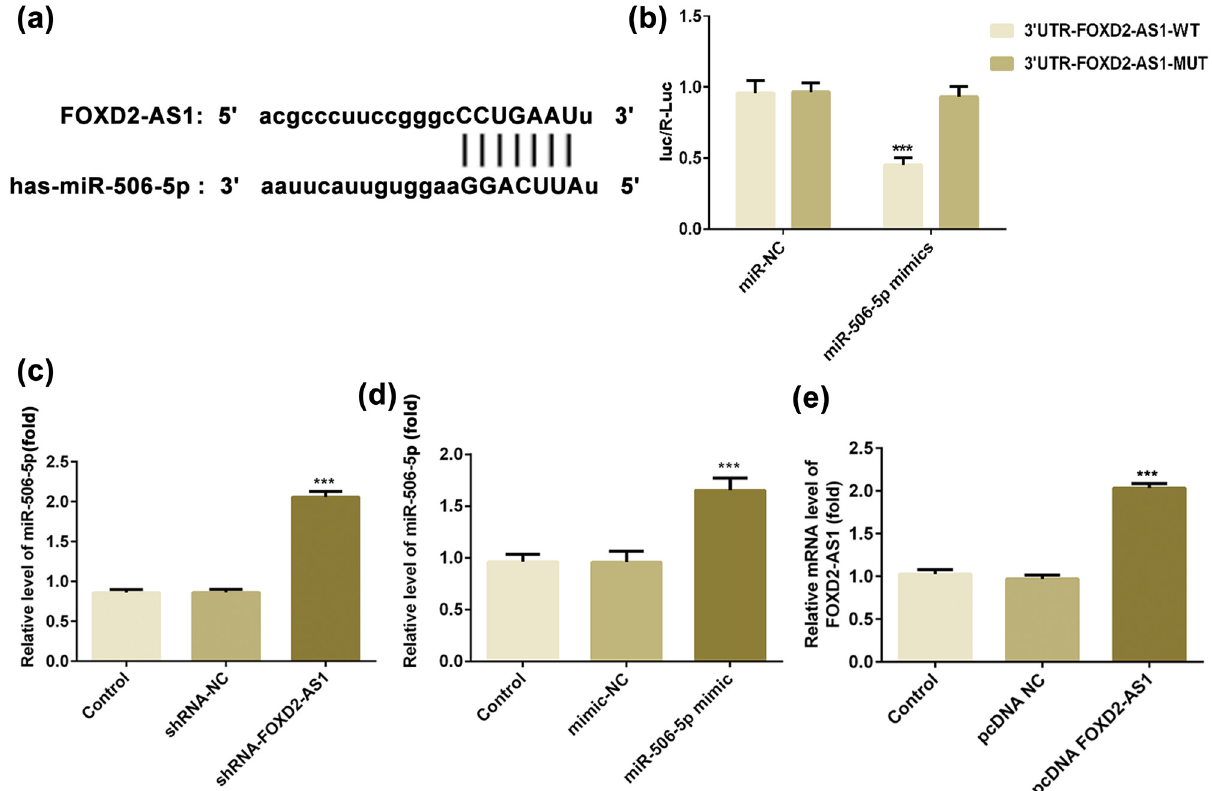
Figure 3: miR - 506 - 5p served as a target of FOXD2 - AS1. ( a ) The binding site between FOXD2 - AS1 and miR - 506 - 5p. ( b ) U251 cells were co - transfected with FOXD2 - AS1 wt or mut plasmids and miR - 506 - 5p mimic or miR - NC, and the luciferase reporter assay showed that the miR